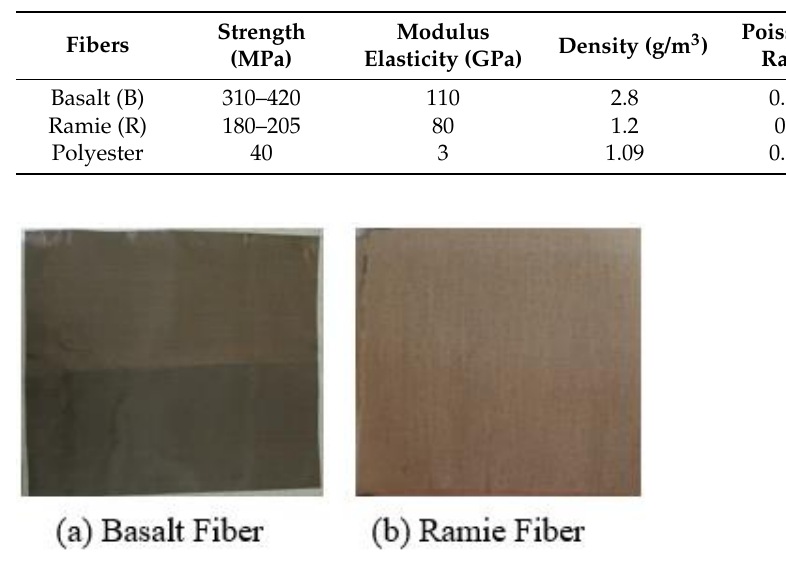
Table 1. Physical characteristics of materials.